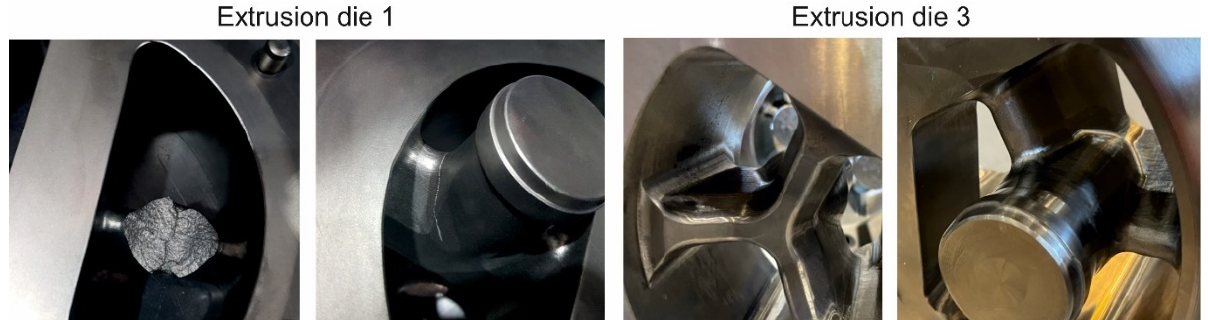
Figure 15. Porthole dies after extrusion of tubes of Ø50 × 2 mm from 7021 alloy; broken mandrel view for extrusion die 1 (on the left), bridge and mandrel view for extrusion die 3, free from cracking (on the right).